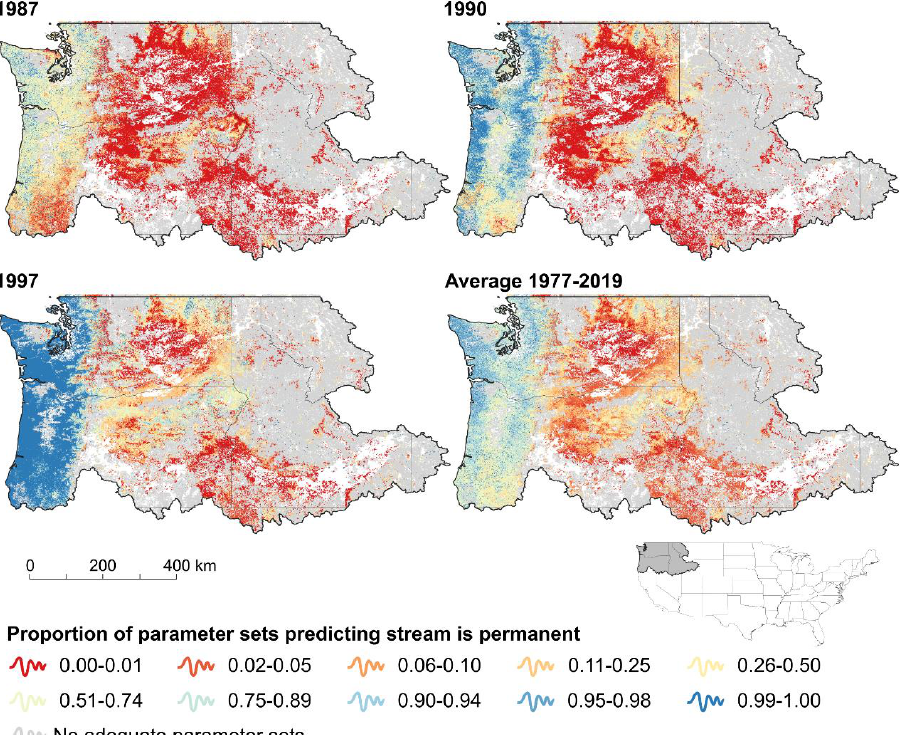
Figure 9. Model precision estimates for headwater streams in the Pacific Northwest during a drier than normal year (1987), approximately normal year (1990), wetter than normal year (1997), and the averaged precision estimates for the entire modeled period (1977–2019). Darker blue represents greater precision for a permanent classification and darker red represents greater precision for a non-permanent classification. Yellow indicates stream reaches with poor precision for the permanence classification.